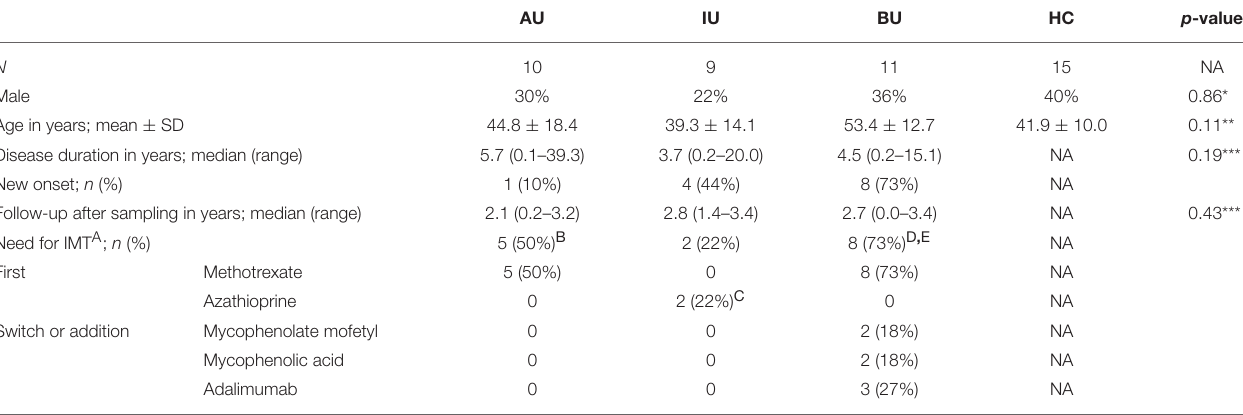
TABLE 1 | Characteristics of the cohort investigated in this study.